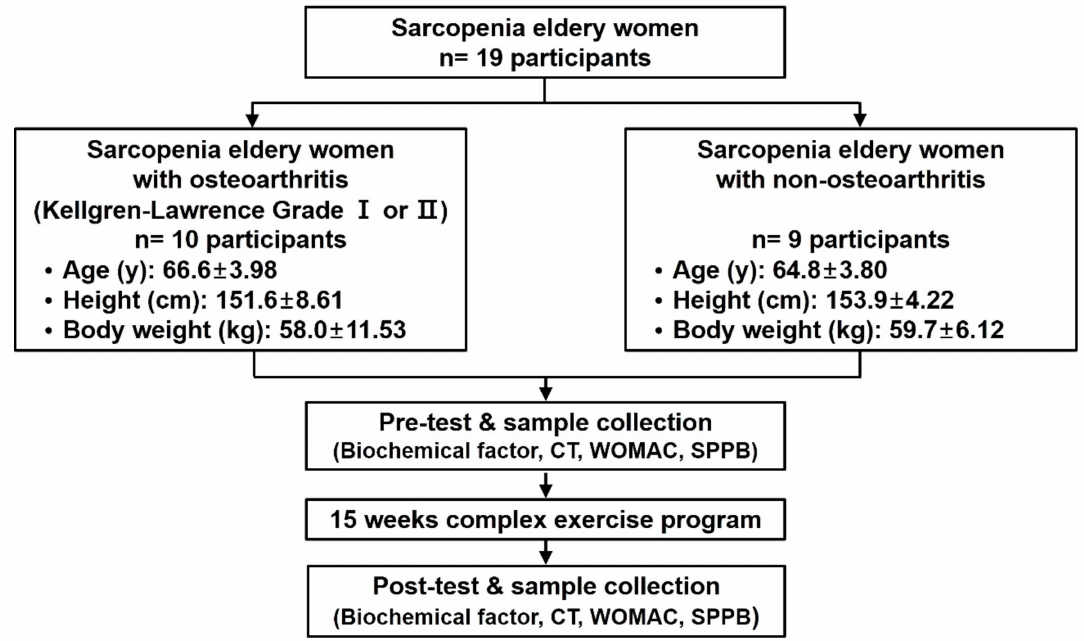
Figure 1. Inspection processes and procedures. WOMAC, Western Ontario and McMaster Universities Osteoarthritis Index; SPPB, Short Physical Performance